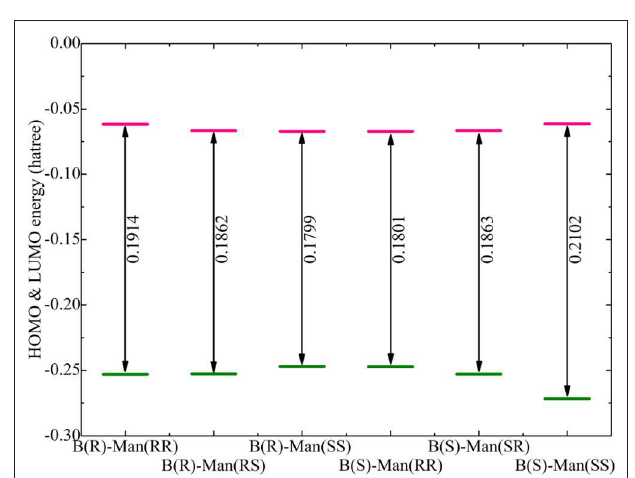
FIGURE 6 | Computational HOMO and LUMO energies (in Hartree), and energy gaps (LUMO-HOMO) for Li[BMB] ion-pair complexes with anions of varied molecular chiralities. These computational results were obtained from DFT calculations at the B3LYP/6-311+G(d) level of theory with Grimme’s-D3 dispersion